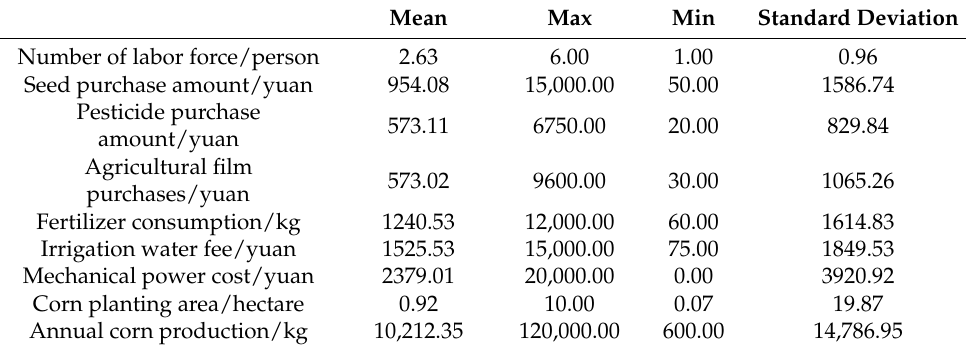
Table 2. Statistical description of inputs and outputs for seed corn